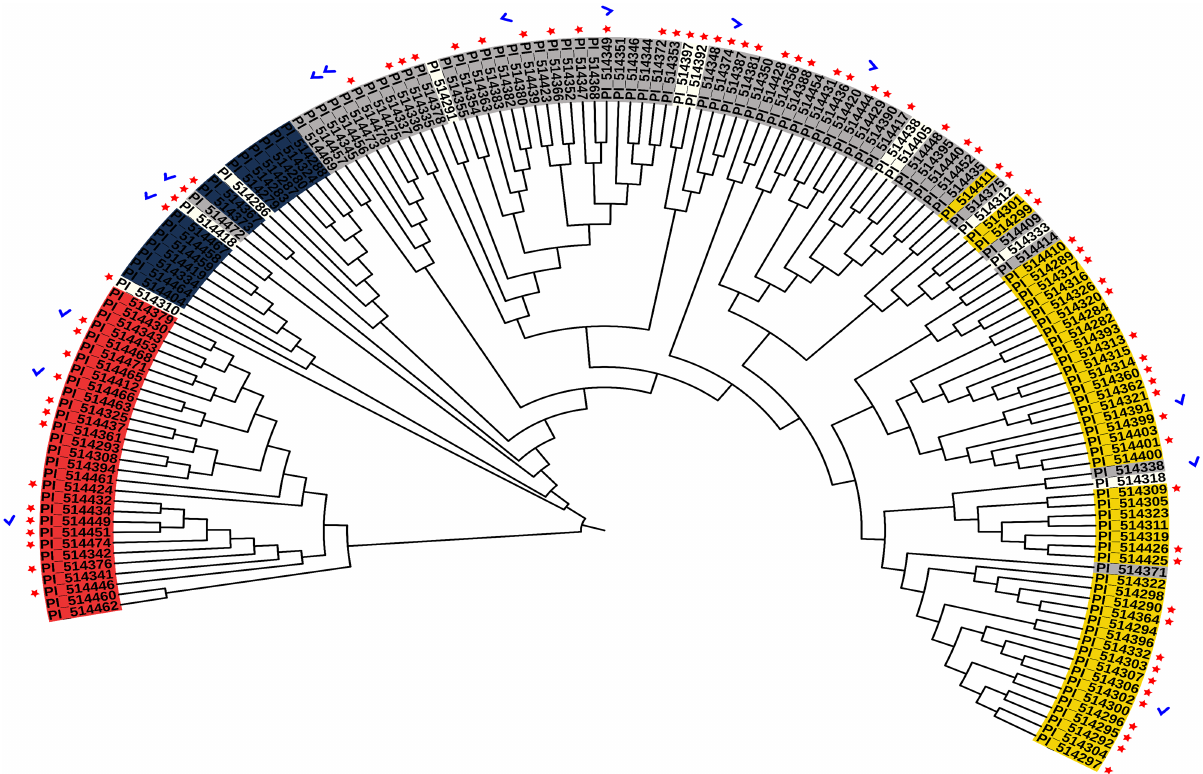
Fig 3. Neighbor-joining tree of 158 NPGS Senegalese accessions. Admixture accessions are not colored. Red stars and blue check marks refer to anthracnose and grain mold resistant accessions, respectively.